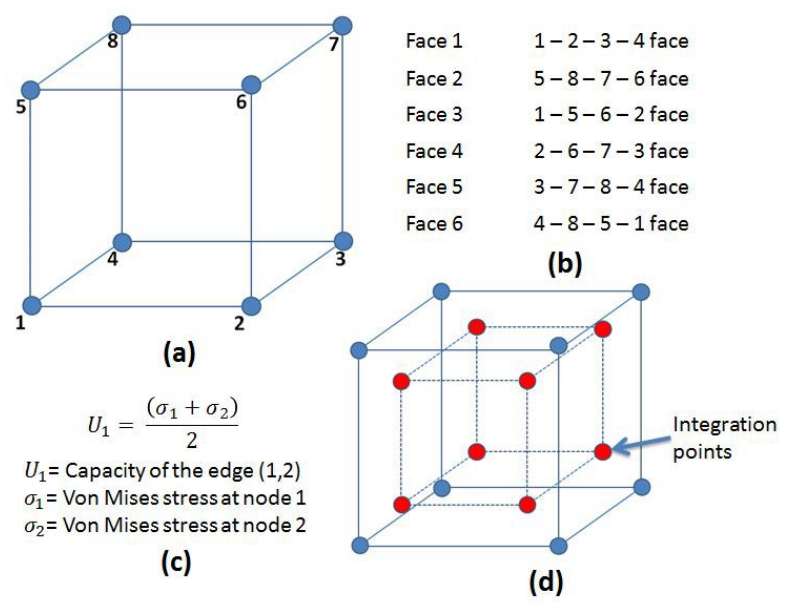
Figure 2. ( a ) Node numbering in an eight-node hexahedral element. ( b ) Hexahedral element faces in an eight-node hexahedral element. ( c ) Capacity calculation for edges in flow network graph. ( d ) Integration points on an eight‐node hexahedral.